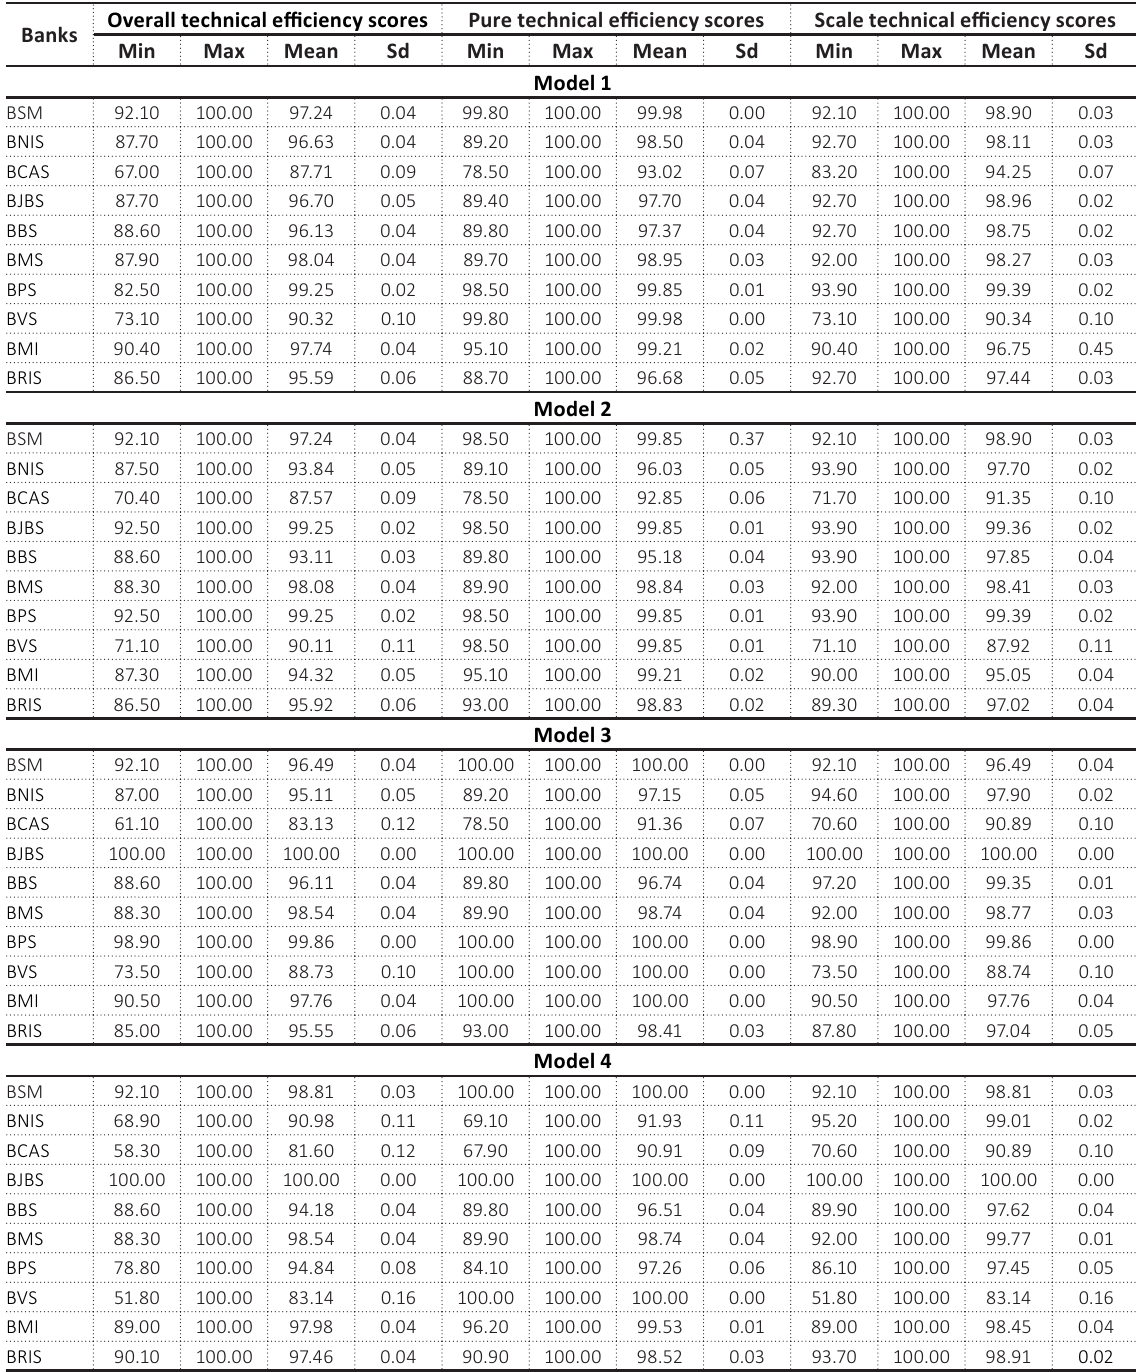
Table 4. Descriptive statistics of efficiency scores across